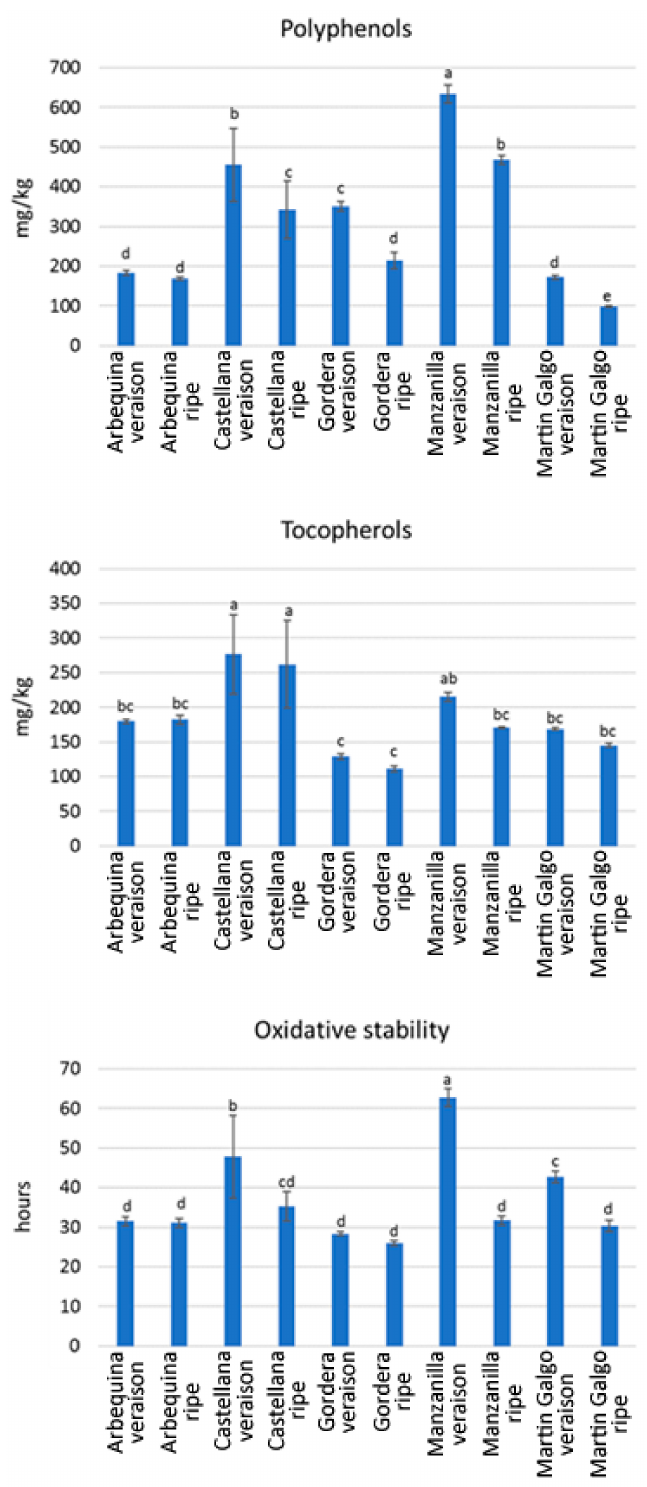
Figure 3. Stability parameters evaluated of the virgin olive oil samples analyzed, from the di ff erent olive varieties grown in the study area, collected at di ff erent stages of maturation. Di ff erent letters on the figure indicate significant di ff erences among cultivars. Duncan test ( p <